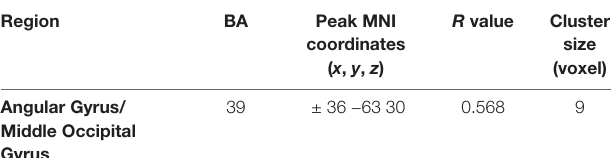
TABLE 3 | Regions showing significant correlations between VMHC value and illness duration in OCD patients.